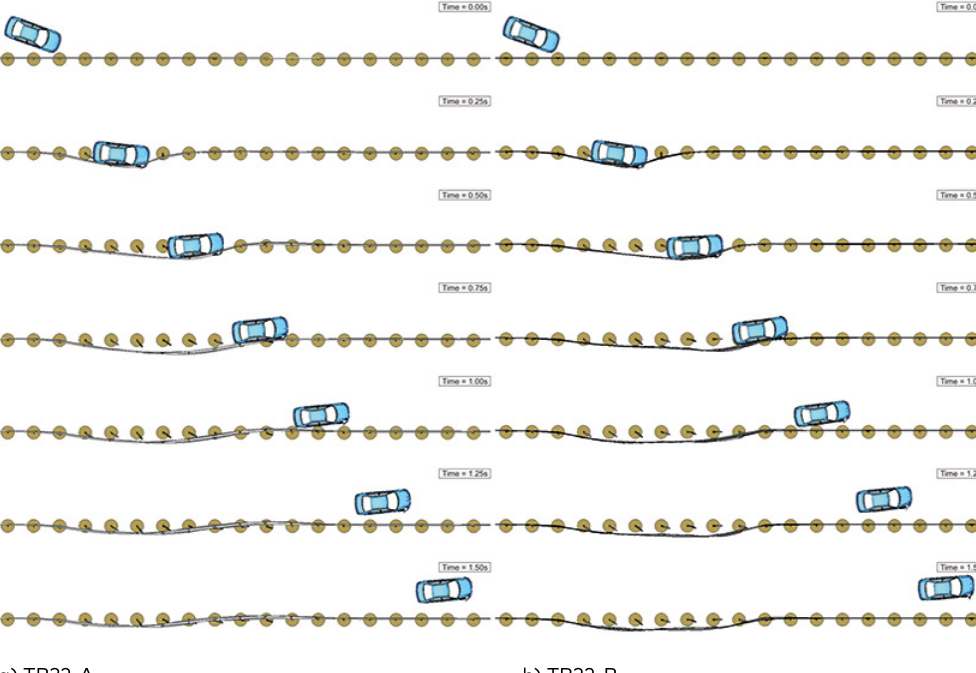
Figure 15. Crash test simulation (view from